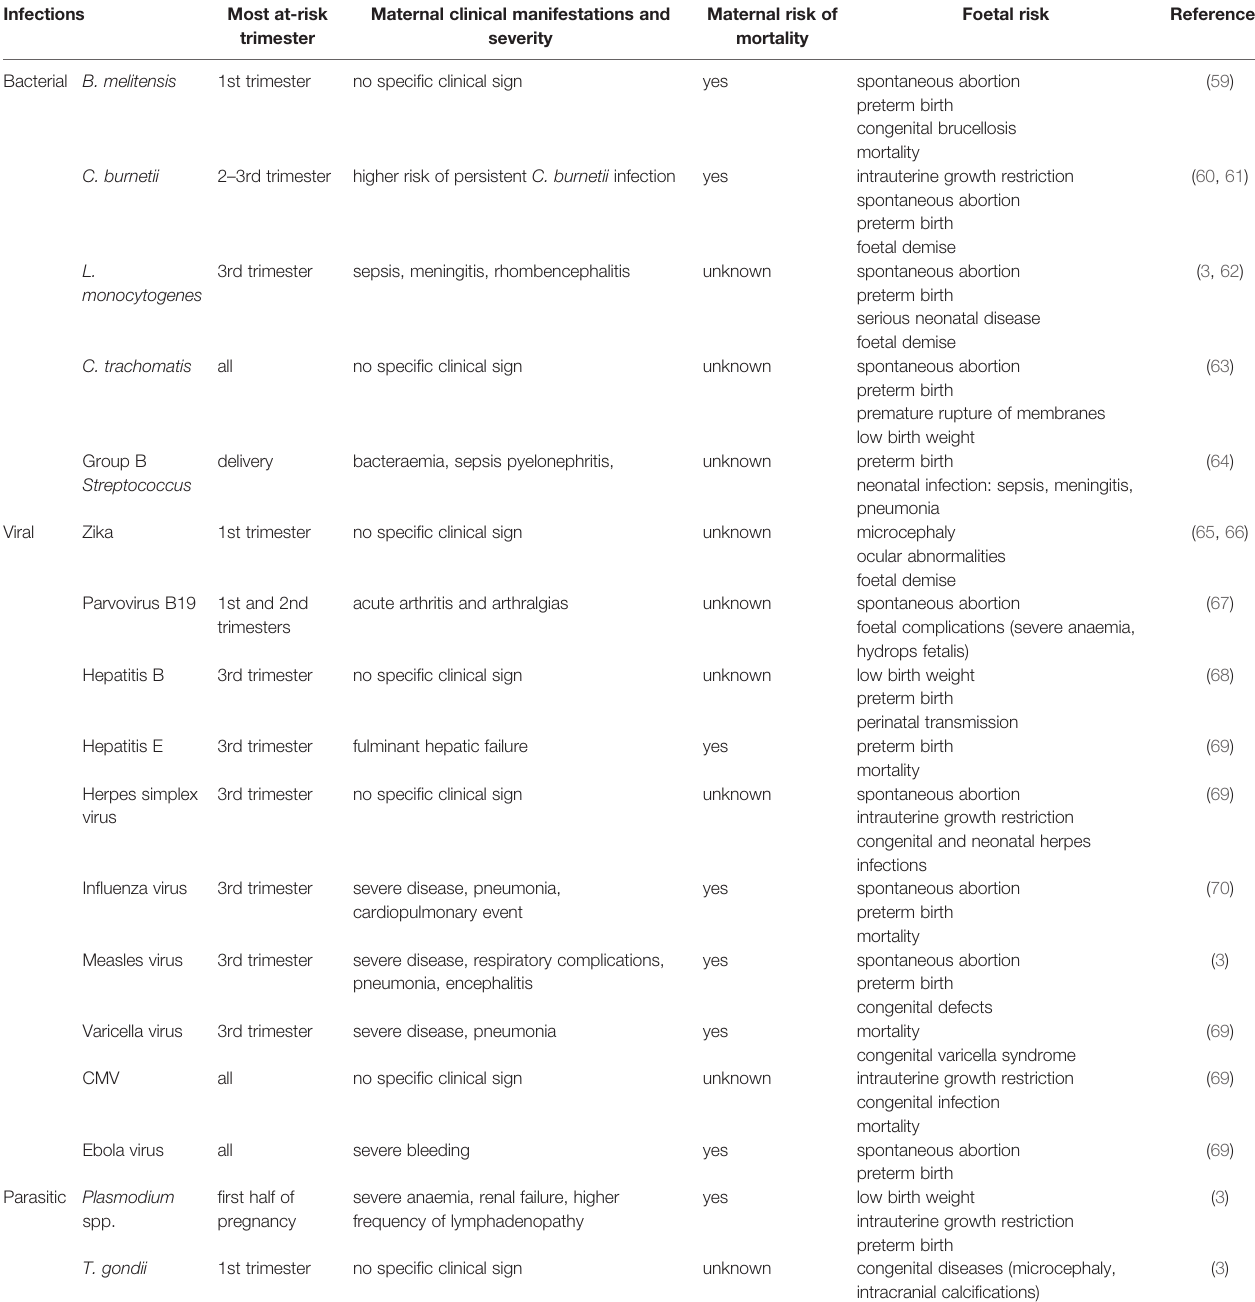
TABLE 2 | Infections that cause adverse pregnancy or foetal outcomes.